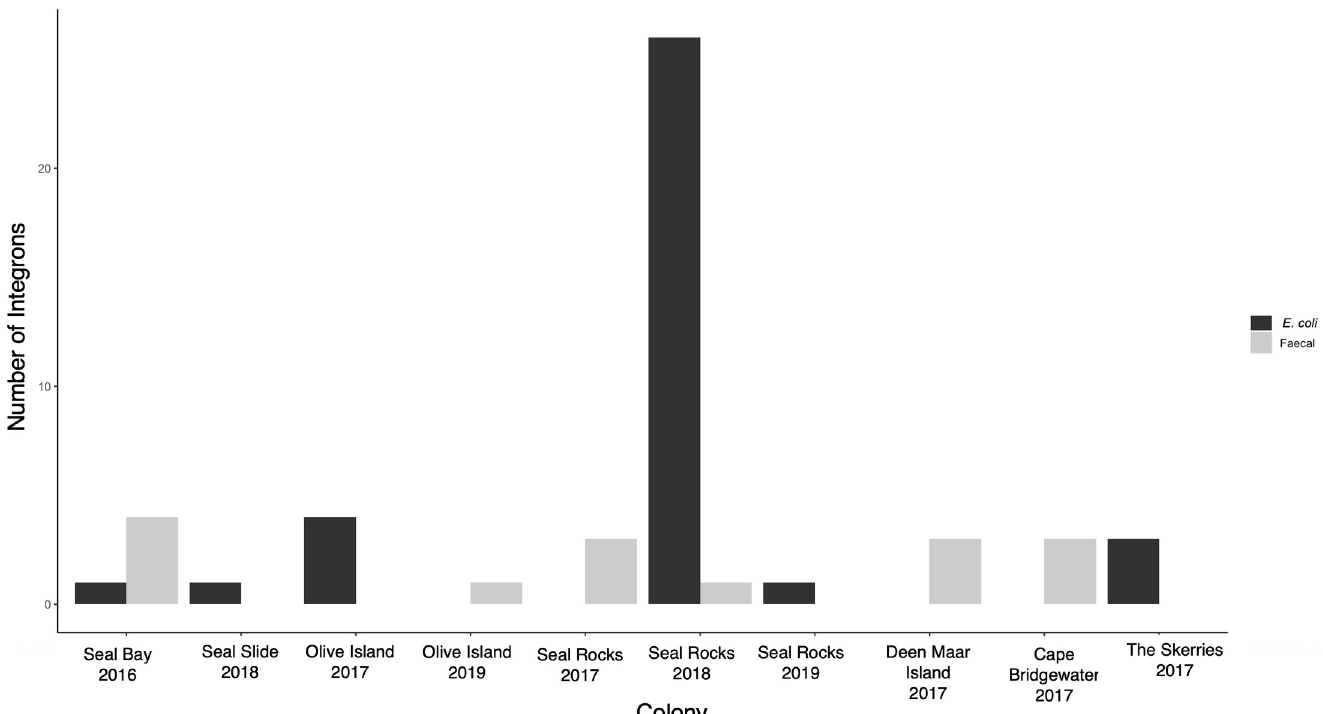
Fig 2. Graph of class 1 integrons detected in pinniped pups. Total number of class 1 integrons detected in faecal and E . coli isolate DNA in pups at each colony where integrons were detected during each breeding season sampled.